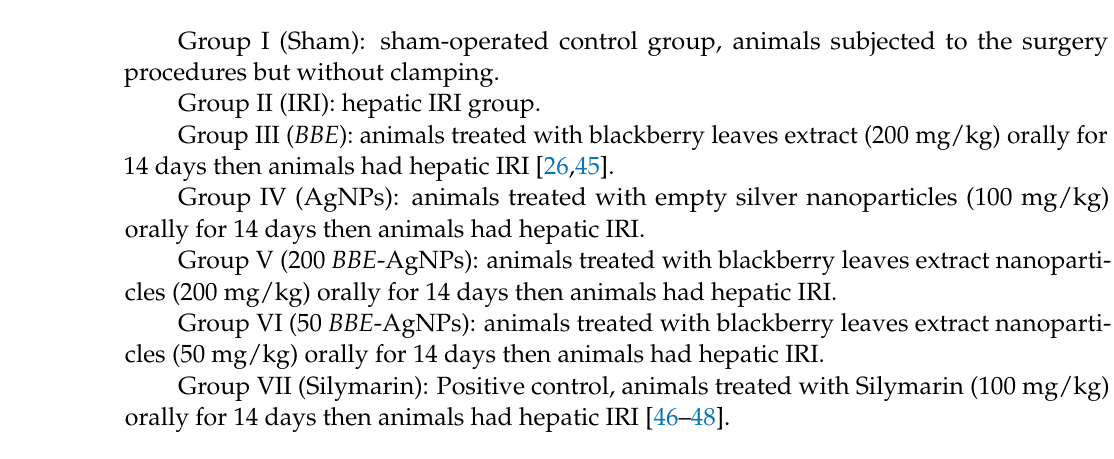
Figure 1. The Experimental Design (created with